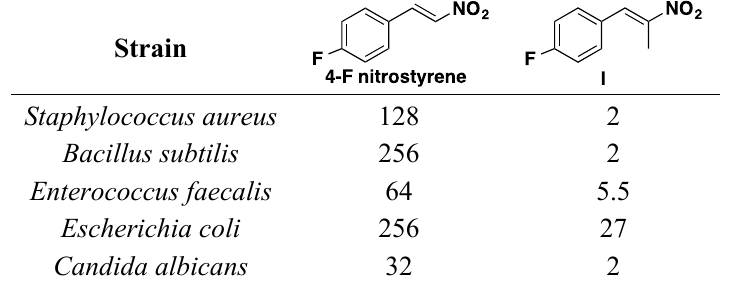
Table 3. Comparative MIC ( μg/mL ) values of 4-F-nitrostyrene and Compound I